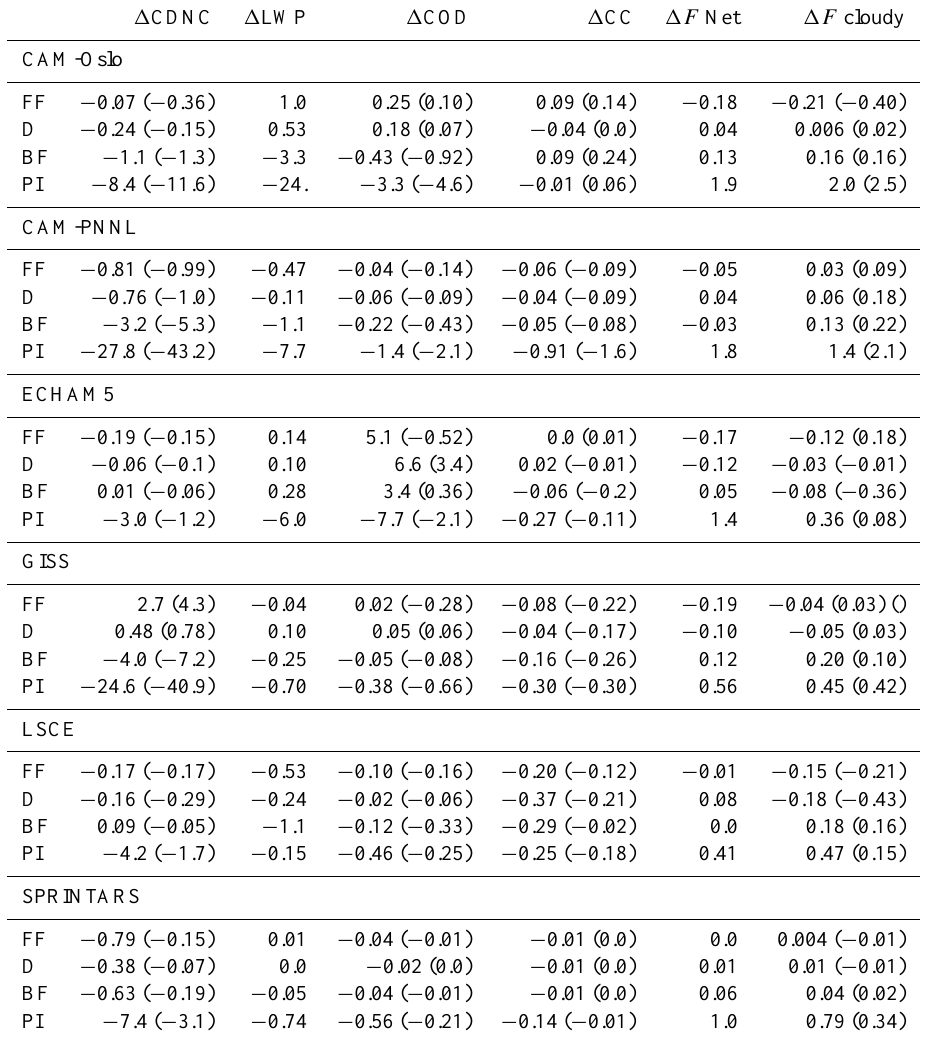
Table 4. Global mean (NH mean) model cloud responses due to reductions of fossil fuel (FF), diesel (D) and biofuel (BF) soot (BF), and all pollution